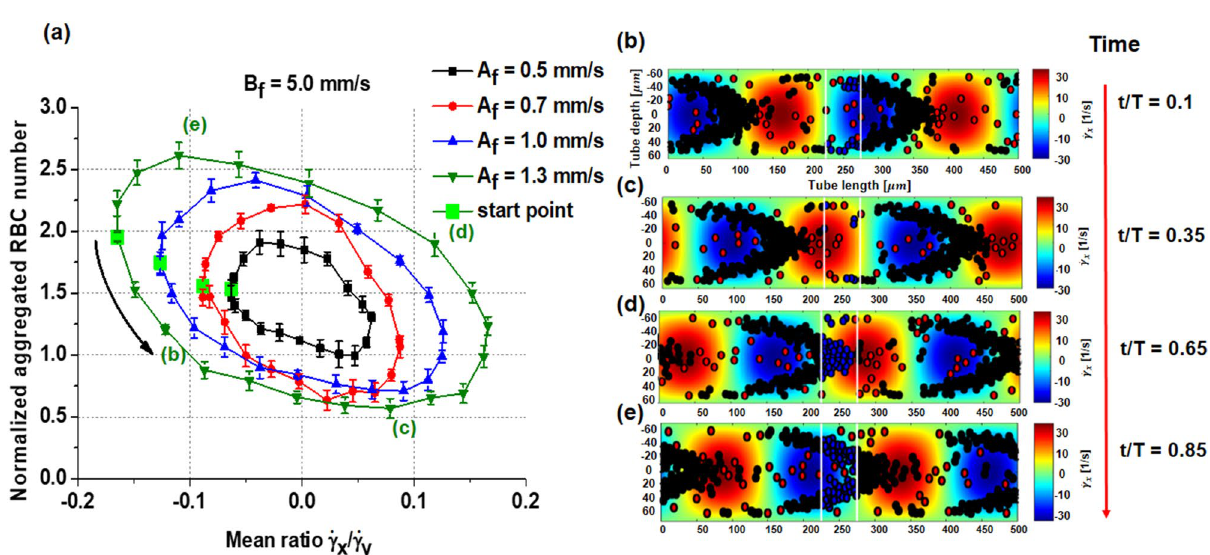
Figure 6. RBC aggregation with mean ratio of axial shear rate ( ˙ γ x ) to radial shear rate ( ˙ γ y ) in the rectangular 2 ROI (0.1 × 0.1 mm , white box near the tube center in the right panels) and its distribution with time over a pulsatile cycle. ( a ) With four different amplitudes of velocity, the normalized numbers of aggregated RBCs are shown as a function of mean shear rate ratio starting from the start points (green markers) in a counterclockwise direction during a cycle. The symbols and error bars are means and standard deviations over five cycles. ( b – e ) Corresponding RBC distributions overlapped with the axial shear rate at the normalized times of 0.1, 0.35, 0.65, and 0.85 in a period. The moments are marked in the left figures with a green solid line ( A f = 1.3mm / s ). The aggregated RBCs (blue particles) were normalized over RBCs randomly distributed at the initial condition in the rectangular